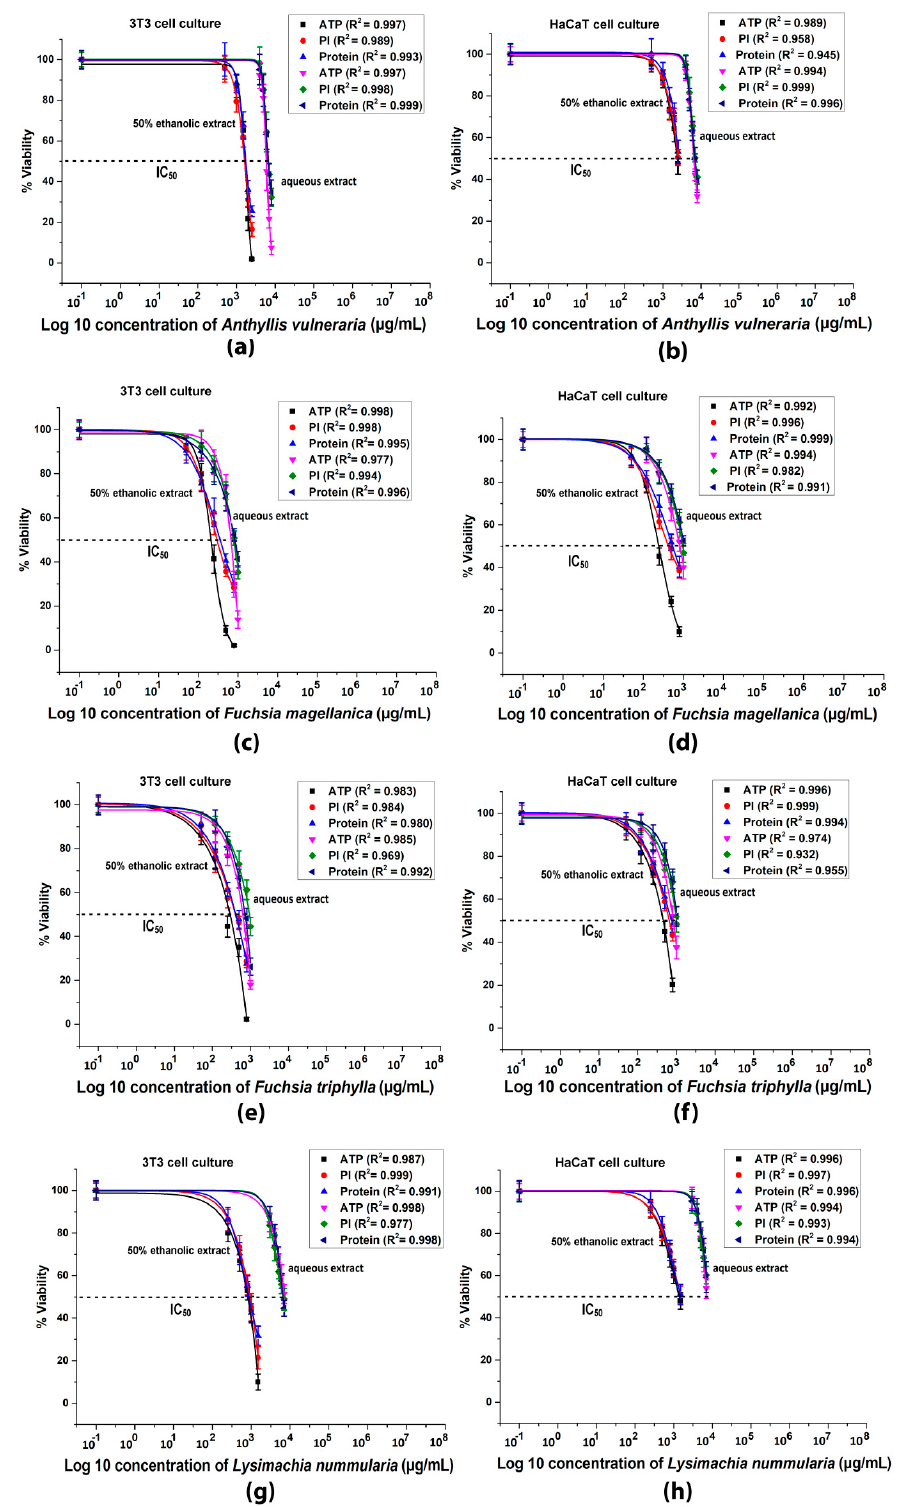
Figure 5. Intracellular ATP content, cell number (PI) and total protein levels of 3T3 and HaCaT cells with dose-response fitting: ( a , b ) cytotoxic e ff ects of A. vulnearia on 3T3 and HaCaT cells; ( c, d ) cytotoxic e ff ects of F. magellanica on 3T3 and HaCaT cells; ( e , f ) cytotoxic e ff ects of F. triphylla on 3T3 and HaCaT cells; ( g , h ) cytotoxic e ff ects of L. nummularia on 3T3 and HaCaT cells. Data are expressed in % of the control. Mean ± SD of 5 independent experiments, n = 5 × 8 replicates for each concentration. Dose-response curves were created by log10 transformation and nonlinear curve fitting. Correlation coe ffi cients ( R 2 ) were calculated for each